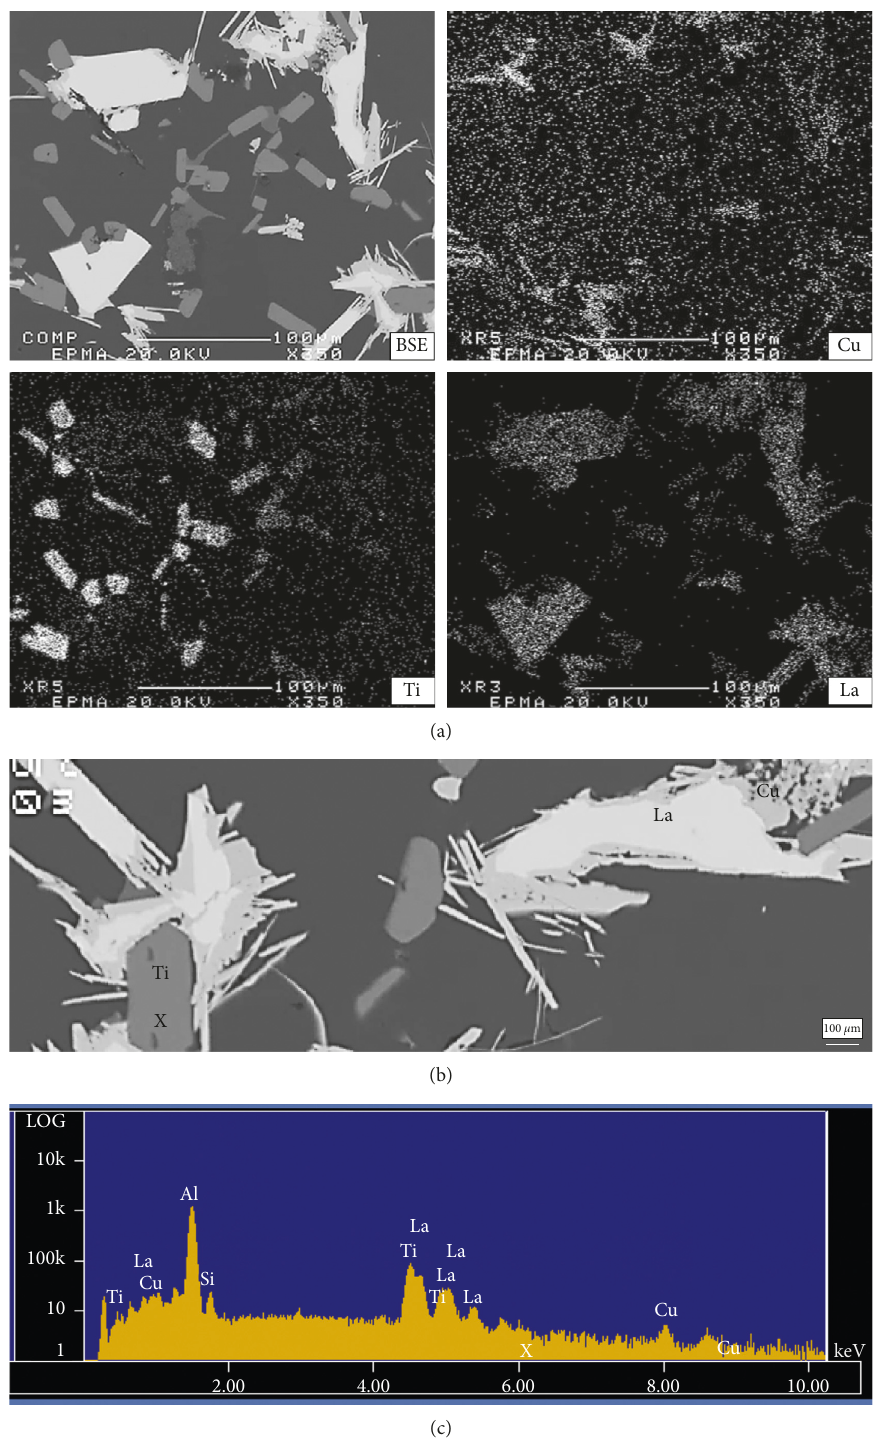
Figure 12: (a) Backscattered electron image and distribution of Cu, Ti, and La in D0+ La+Ti alloy, (b) enlarged micrograph of circled area in (a), and (c) EDS spectrum corresponding to the gray phase marked X in (b). (Note the weak Cu and Si peaks in the gray